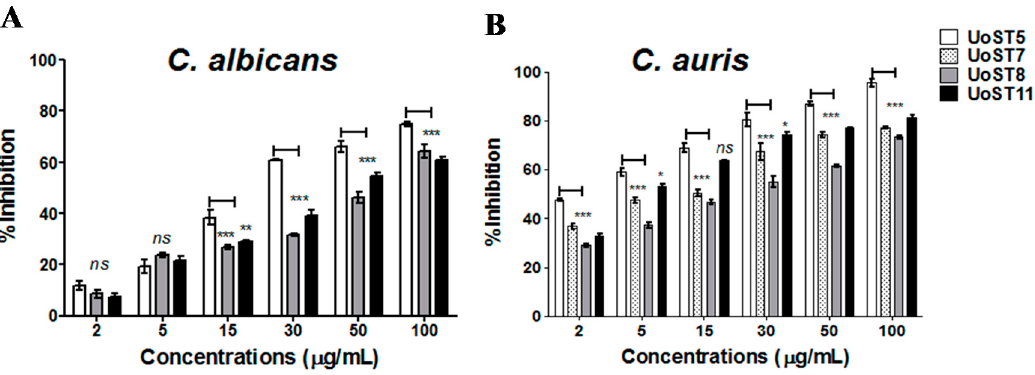
Figure 2. Anti- Candida activities of UoST compounds. ( A ) C. albicans growth inhibition by UoST5 , 8 and 11 compounds at di ff erent concentrations (2, 5, 15, 30, 50, 100 µ g / mL). ( B ) C. auris growth inhibition by UoST5 , 7 , 8 and 11 compounds at di ff erent concentrations (2, 5, 15, 30, 50, 100 µ g / mL). Candida at 10 4 CFU / mL was grown in 96 well microplate containing YPD broth. The plates were incubated at 37 ◦ C for 24 h prior to measurement at 600 nm using plate reader. Cultures without compounds were employed as negative control. The data was analyzed using two-way ANOVA and statistical significance was calculated with Bonferroni’s multiple comparisons test and significance level indicated by asterisks (* P < 0.05; ** P < 0.01: *** P < 0.001). The data display the mean ± standard error (SEM) of three replicas. Table 1. MIC 50 of UoST compounds against C. auris .